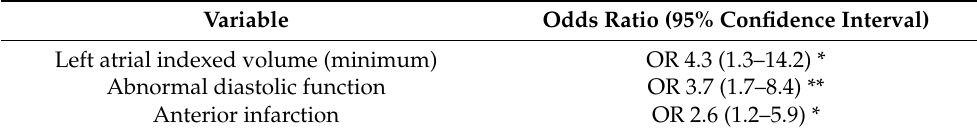
Table 3. Multivariable logistic regression for METs ≤ 8: final model.